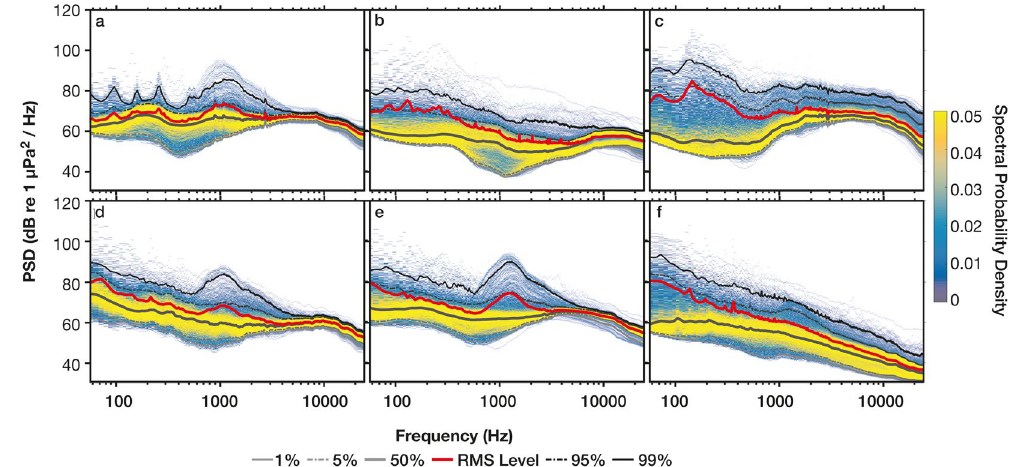
Figure 2. RMS level of the PSD, percentiles and spectral probability density (SPD)) for April 2015 for each of the six listening stations, ( a ) Horn Rock, ( b ) Waiheke Island, ( c ) Bean Rock, ( d ) Shearer Rock, ( e ) Flat Rock, and ( f ) Jellicoe Channel. Spectral probability density is shown by the colour-bar in each